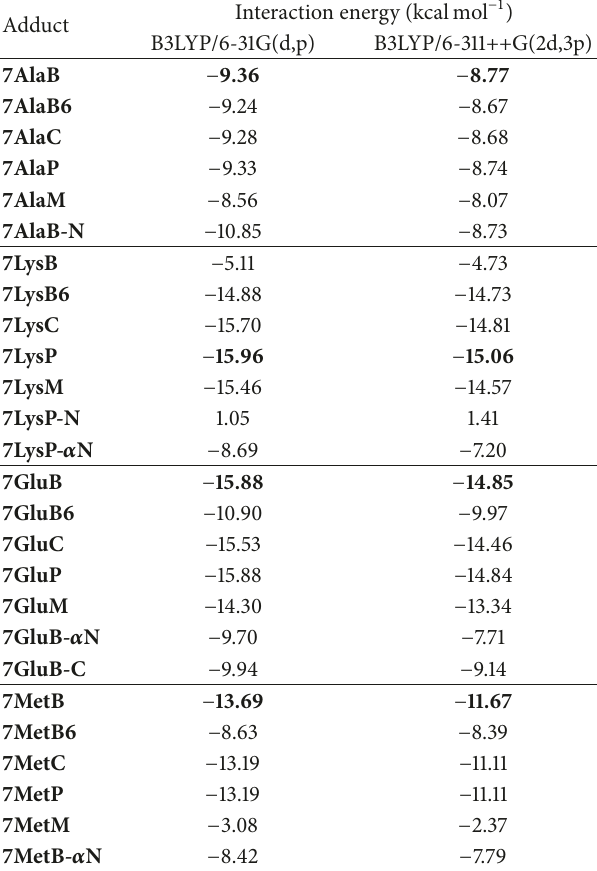
Table 1: Interaction energies between compound 7 andalanine ( 7Ala ), lysine ( 7Lys ), glutamic acid ( 7Glu ), and methionine ( 7Met ). Suffixes added to the names of adducts mean that the structure was optimized at functional: B , B -C , B -N , B - 𝛼 N : B3LYP/6-31G(d,p); B 6 : B3LYP/6-311+G(d,p); C : CAM-B3LYP/6-31G(d,p); P , P-N , P- 𝛼 N : PBE0/6-31G(d,p); M : M06L/6-31G(d,p). Cartesian